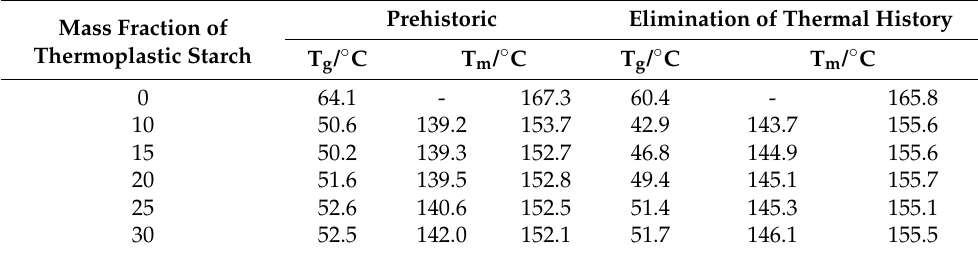
Table 1. The thermal transition temperatures of PLA/thermoplastic starch/SiO 2 composites. Prehistoric Elimination of Thermal Mass Fraction of Thermoplastic Starch